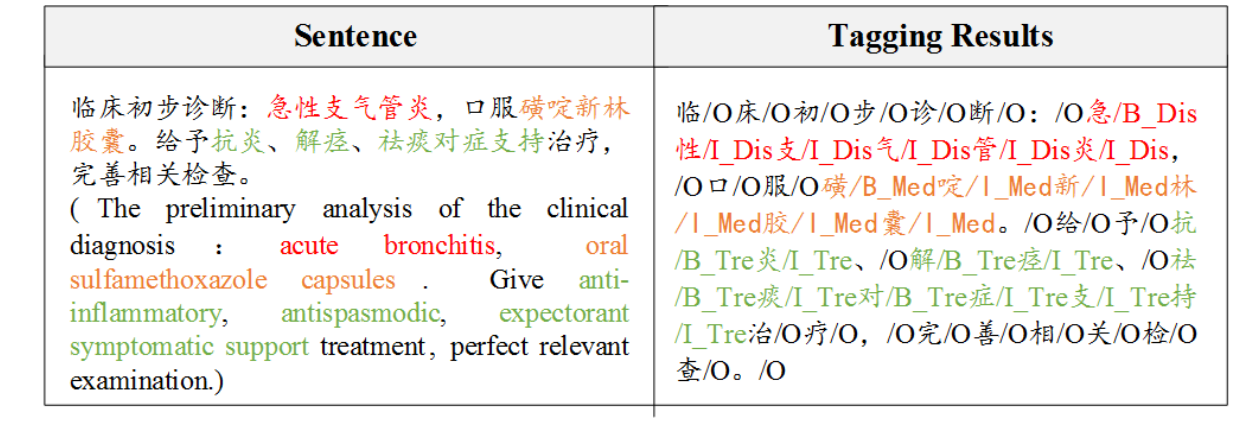
Figure 1. A tagging example of Chinese electronic medical